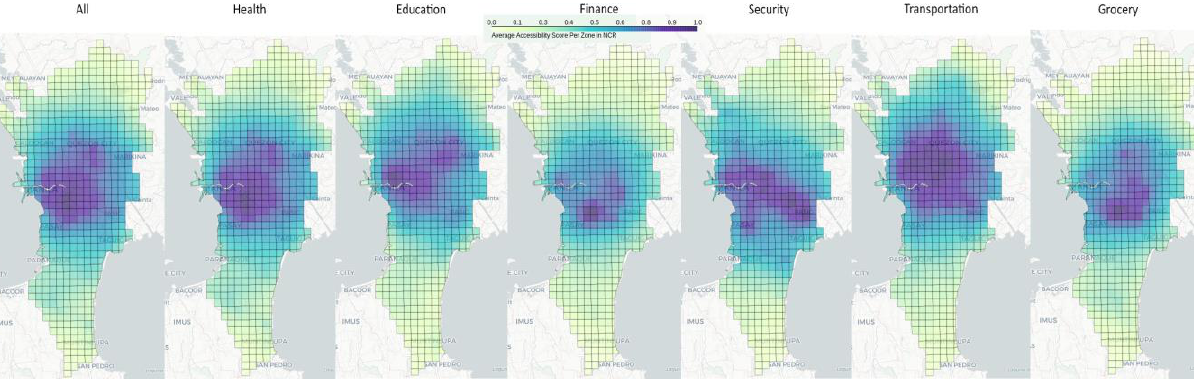
Figure 4 : Amenity Accessibility Scores (Normalized) for All Categories in NCR